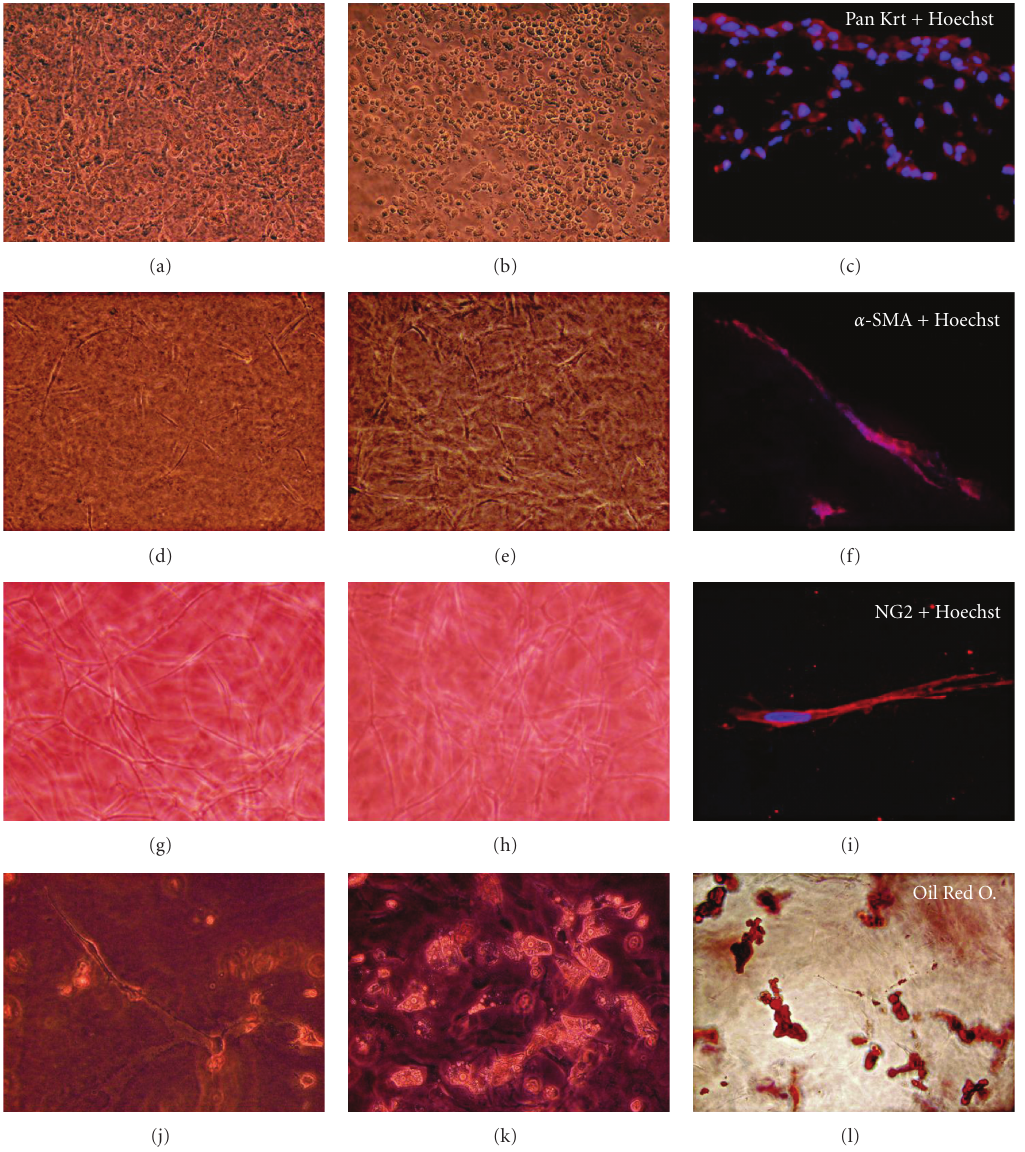
Figure 5: (a and b) Di ff erentiation time course of dsASCs into epithelial-like cells on a collagen hydrogel showing (a) squamous cell-like morphology by day 4 and (b) epithelial-like cuboidal cell morphology by day 12. (c) Immunocytochemical image of section from dsASCs di ff erentiated into epithelial-like cells on collagen gel (day 12) stained with pan cytokeratin. (d, e, g, and h) Di ff erentiation time course of dsASCs in PEGylated-fibrin-collagen bilayer gels exhibiting bidirectional di ff erentiation into fibroblast-like morphology in collagen layer (d; day 6) and tubular structures (g; day 6) in the PEGylated-fibrin layer. By day 12, collagen layers showed an increase in fibroblast-like cells (e) and complex networks in PEGylated-fibrin layers (h). Immunocytochemical image of section from bilayered hydrogel (day 12) depicting dsASCs to maintain stromal phenotype with collagen layer, stained with α -smooth muscle actin (f) and di ff erentiated to vascular phenotype, stained with NG2 (i). (j and k) Di ff erentiation time course of dsASCs into adipocytes on collagen showing appearance of oil vesicles by day 7 (j) and significant accumulation of oil droplets over time (k: day 14). (l) Oil Red O. staining of di ff erentiated dsASCs (day 14) confirming formation of mature adipocytes within collagen gel. Bright field images original magnification: × 100 (a–h and l) and × 200 (j, k). Immunofluorescence original magnification × 400 (c, f, and